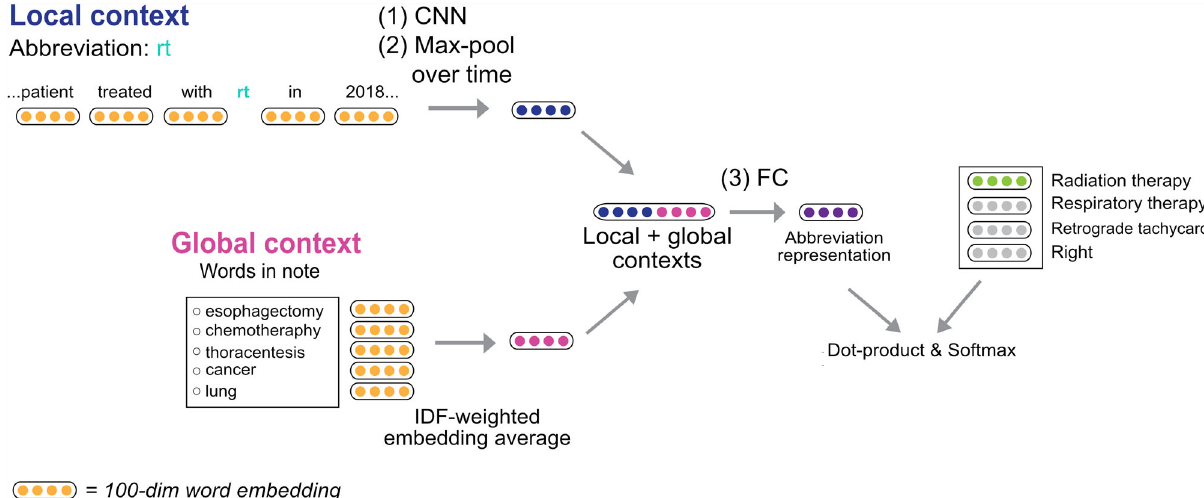
Fig. 5 Overview of our abbreviation disambiguation model. Sentences containing a target concept are passed through a convolutional neural network (CNN) and max-pooled over time to generate an encoding of the local context. Global context takes the IDF-weighted average of word embeddings in the entire document. We combine global context with the output from the sentence encoder and pass it through a fully connected layer (FC). We maximize the dot-product of the encoded sentence and expansion